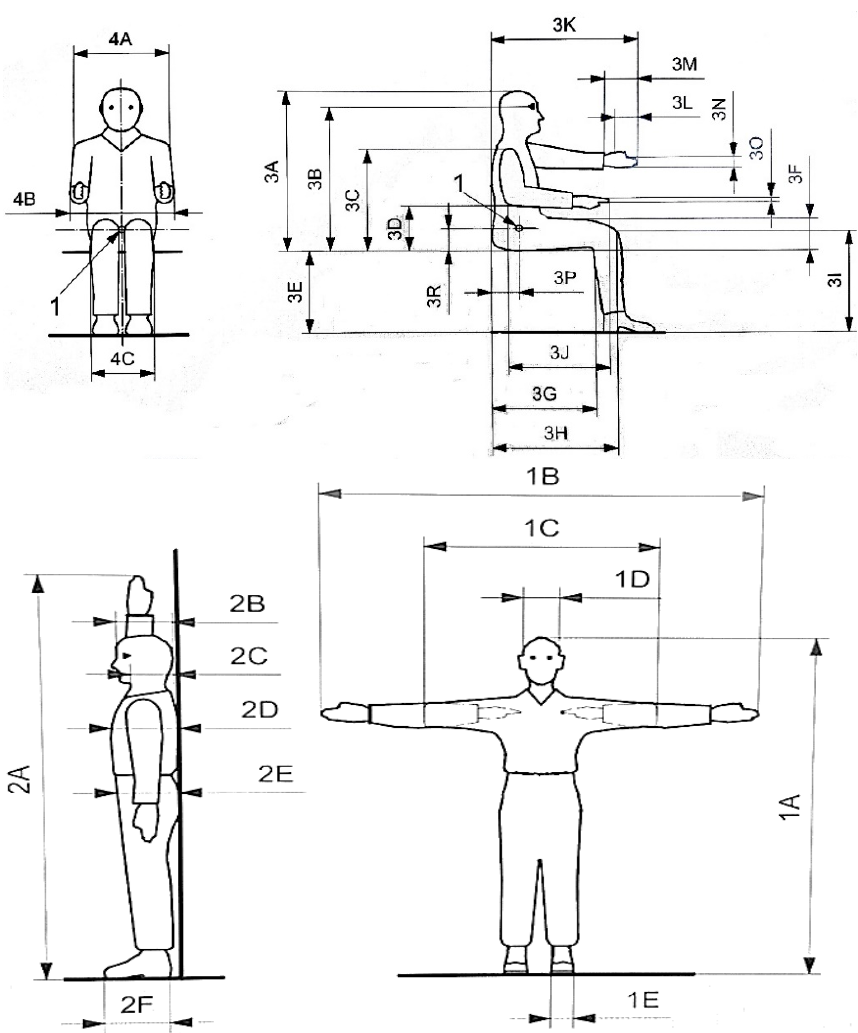
Figure 1. Anthropometric dimensions of the earthmoving machine operator defined by the EN ISO 3411 standard.